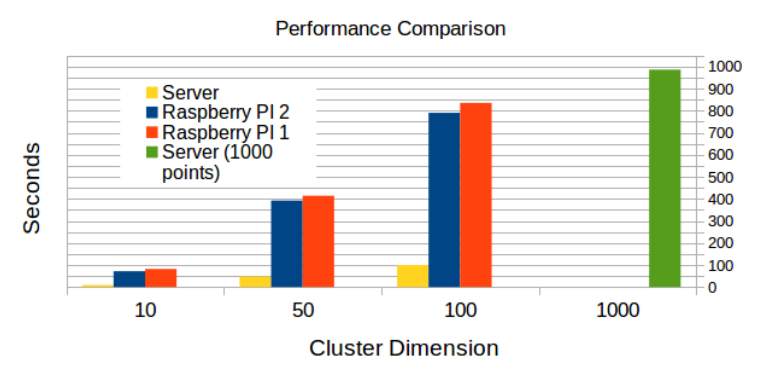
Figure 6. Comparison between Execution Times for different cluster